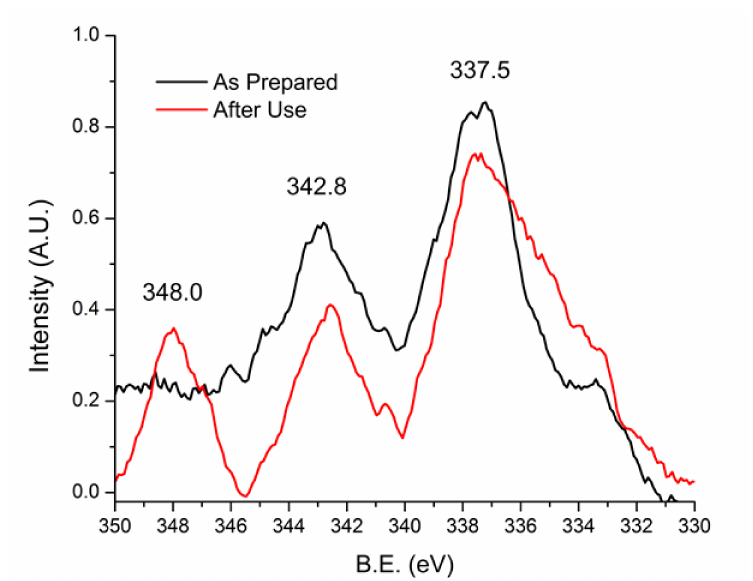
Figure 7. Before and after use (1.5 h − 0.4 V vs. Ag / AgCl / sat. KCl) Pd XPS spectra of the